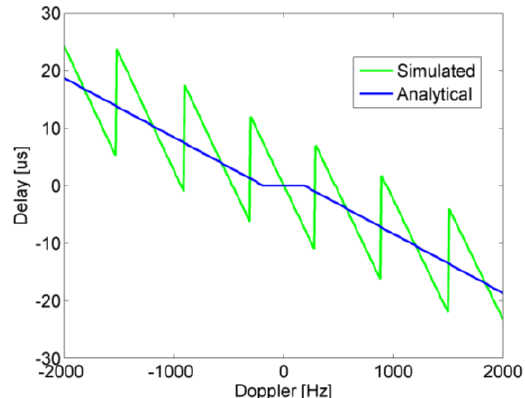
Figure 9. Time delays due to Doppler shifts for analytical function and